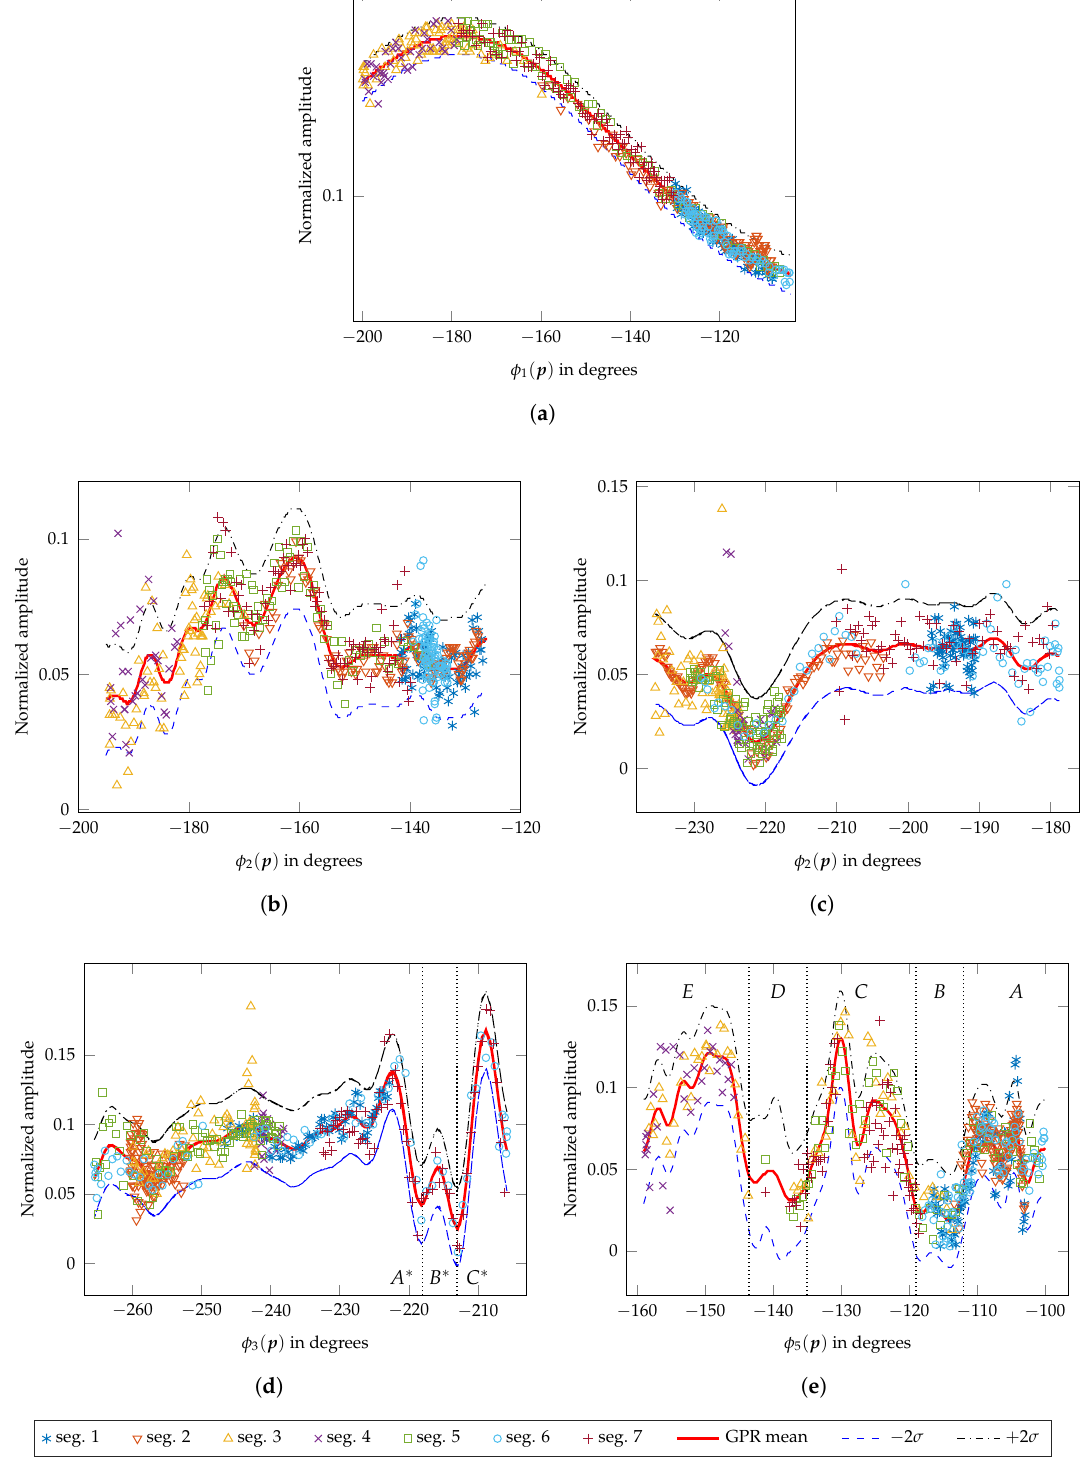
Figure 3. GP regression of SMC amplitude for ( a ) LOS amplitude associated with anchor 1 at a ( 1 ) ( b ) the SMC amplitude of VA at a ( 1 ) associated with anchor 1 (east plaster board wall), ( c ) the SMC 2 amplitude of VA at a ( 2 ) associated with anchor 2 (east plaster board wall), ( d ) the SMC amplitude of 2 VA at a ( 2 ) associated with anchor 2 (south wall), ( e ) the SMC amplitude of VA at a ( 1 ) 3 anchor 1 (north glass